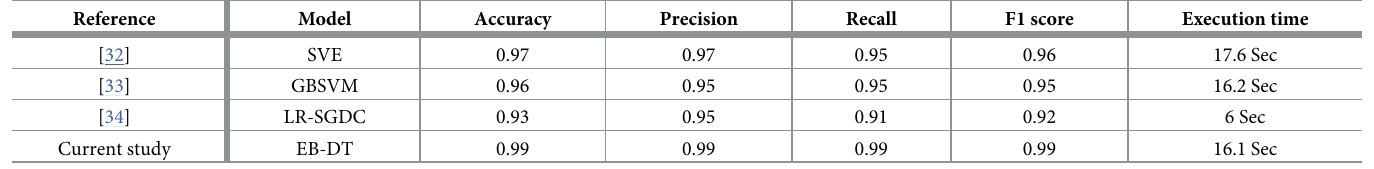
Table 8. Performance comparison with previous